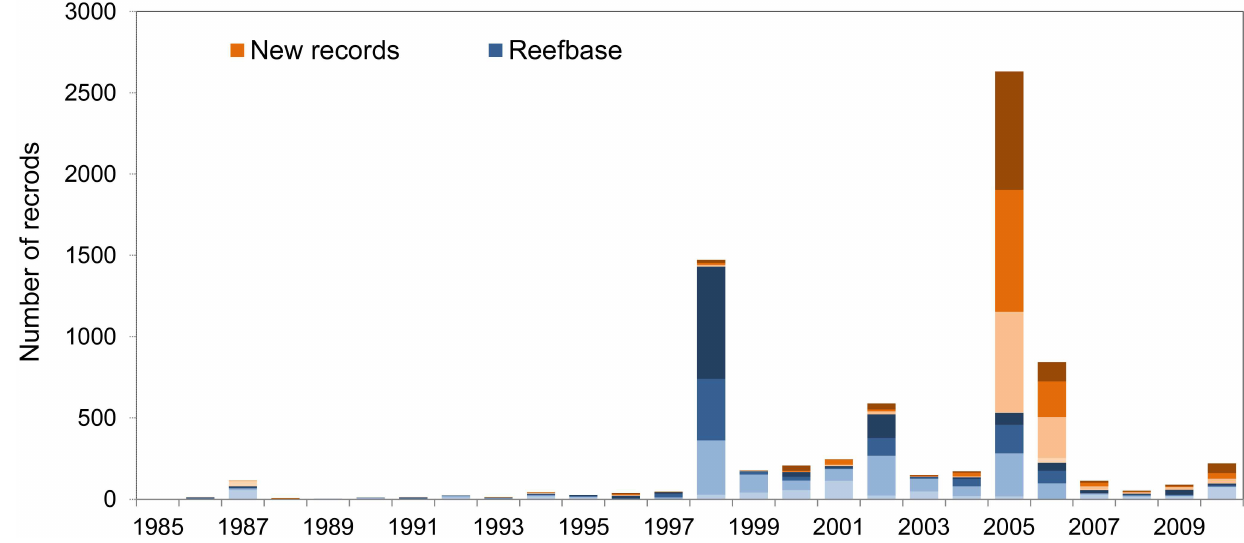
Fig 1. Annual number of bleaching observations for 1985–2010. Blue bars represent originalReefBasereports; orangebars represent new reports. Shadingreflects bleachinglevel, from mild (1–10%) or unknownextent of bleaching (levels 1 and -1 in Table 2, lightest colour) to severe ( > 50%)bleaching (level 3, darkest